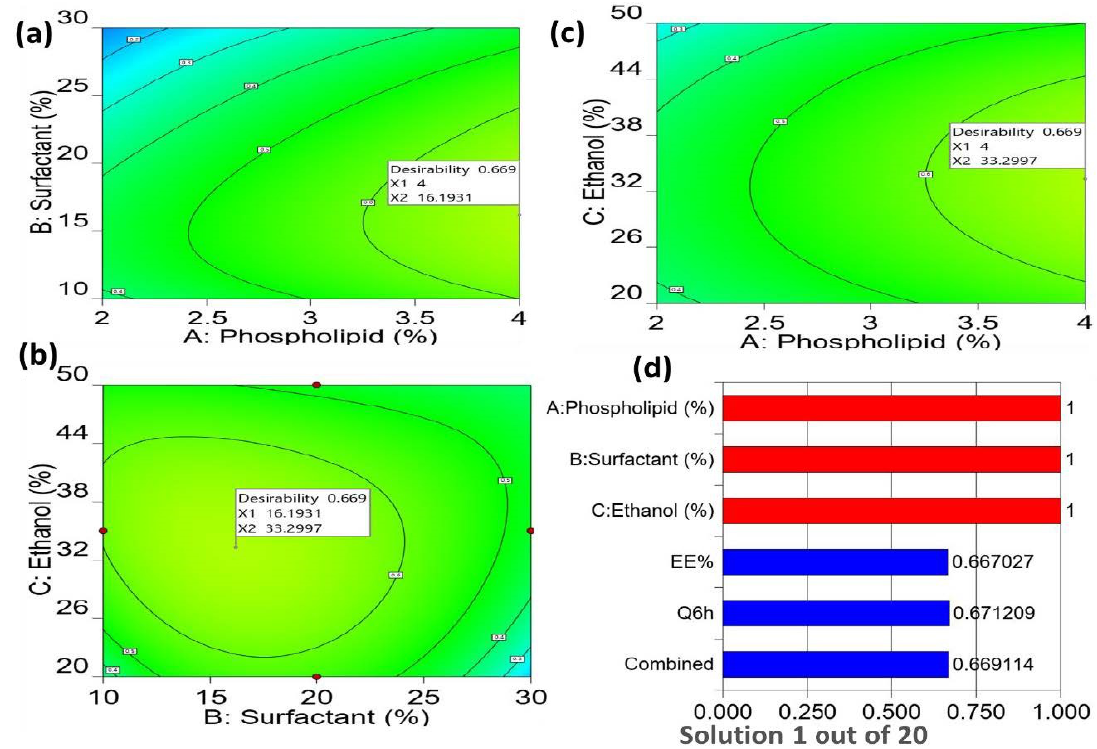
Figure 3. 2D contour plot for desirability function displaying the effect of independent factors on the overall responses ( a – c ); and desirability bar graph displaying the overall desirability of each response and combined optimization ( d